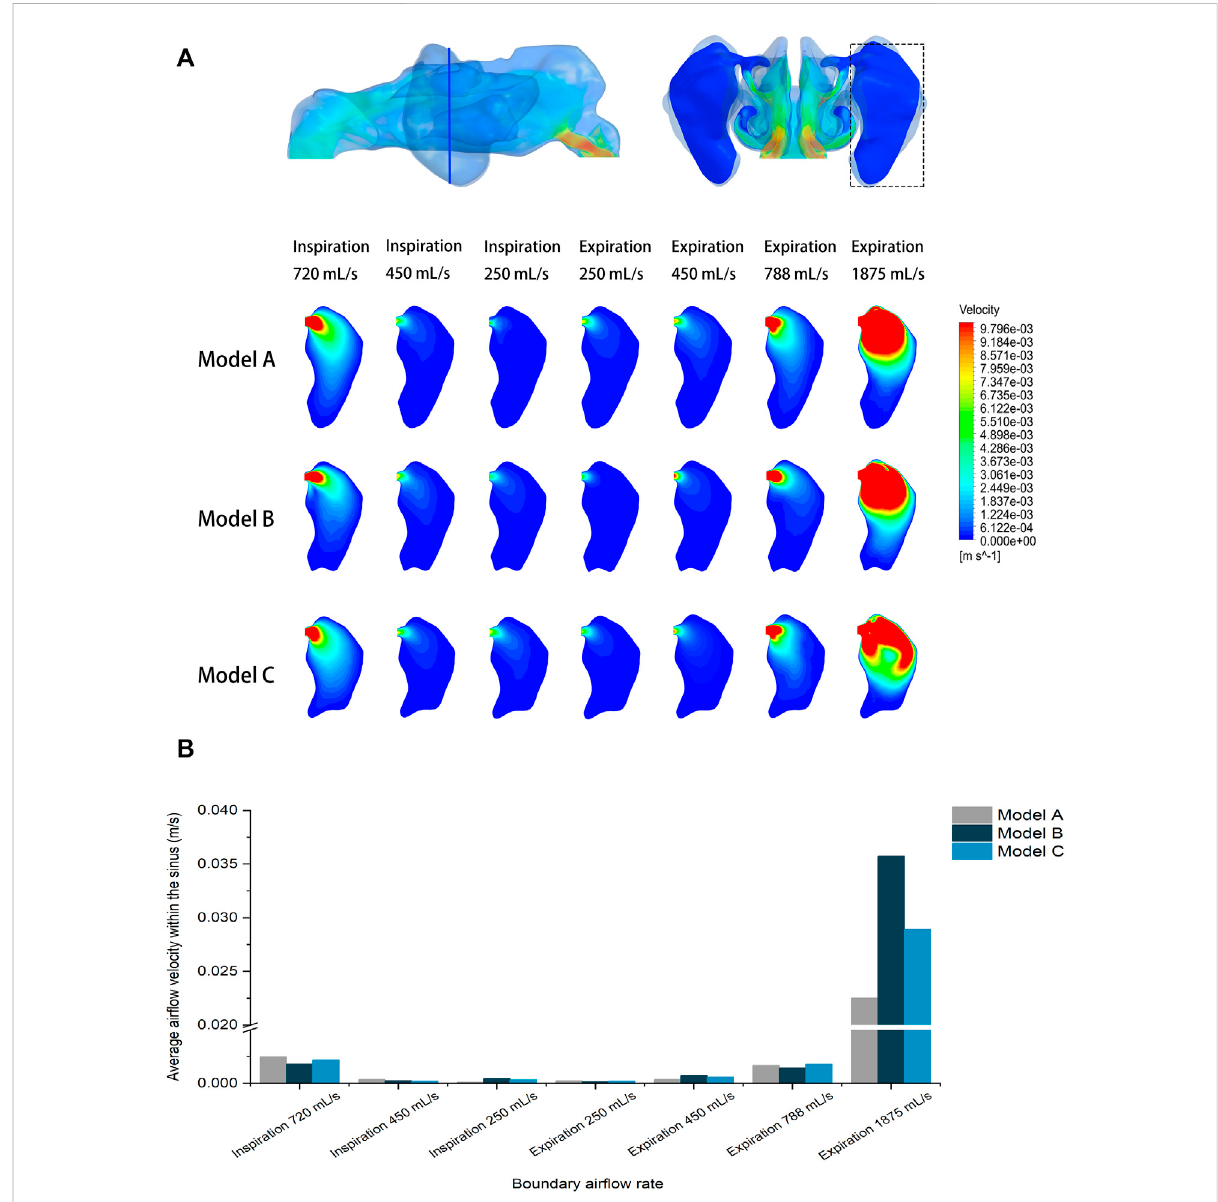
FIGURE 3 (A) Velocity distribution at the cross-section plane of the pre- and post-operative sinuses under different inlet fl ow rates. (B) Quantitative comparison of average air fl ow velocity within the pre- and post-operative sinuses under different fl ow